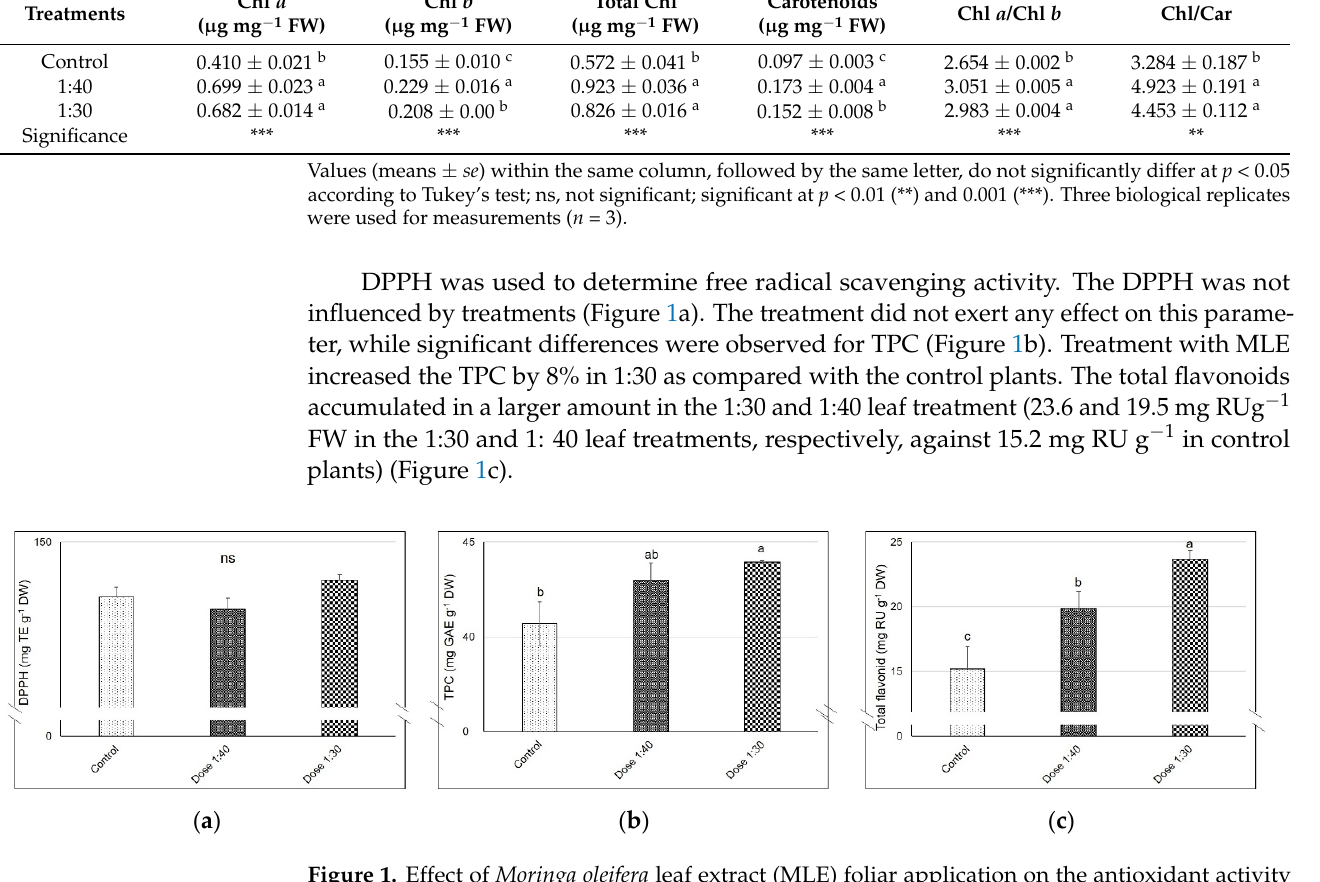
Figure 2. Effect of Moringa oleifera leaf extract (MLE) foliar application on total sugars ( a ) (mg g − 1 FW) and ascorbic acid (Asc) ( b ) (mg g − 1 FW) of radish baby leaf. Data are means ± standard error ( n